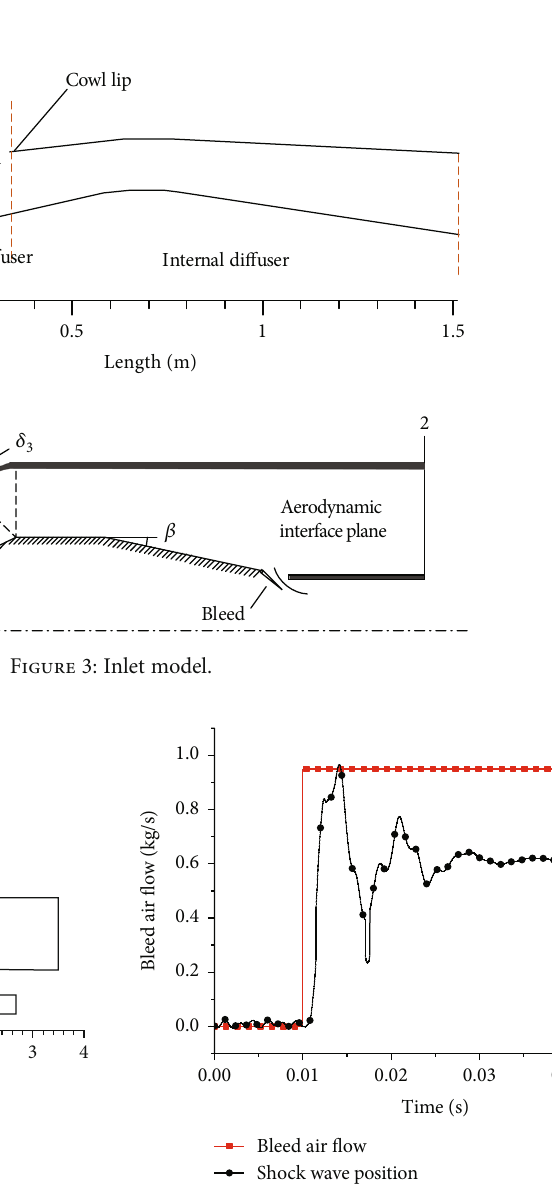
Figure 5: Shock wave position